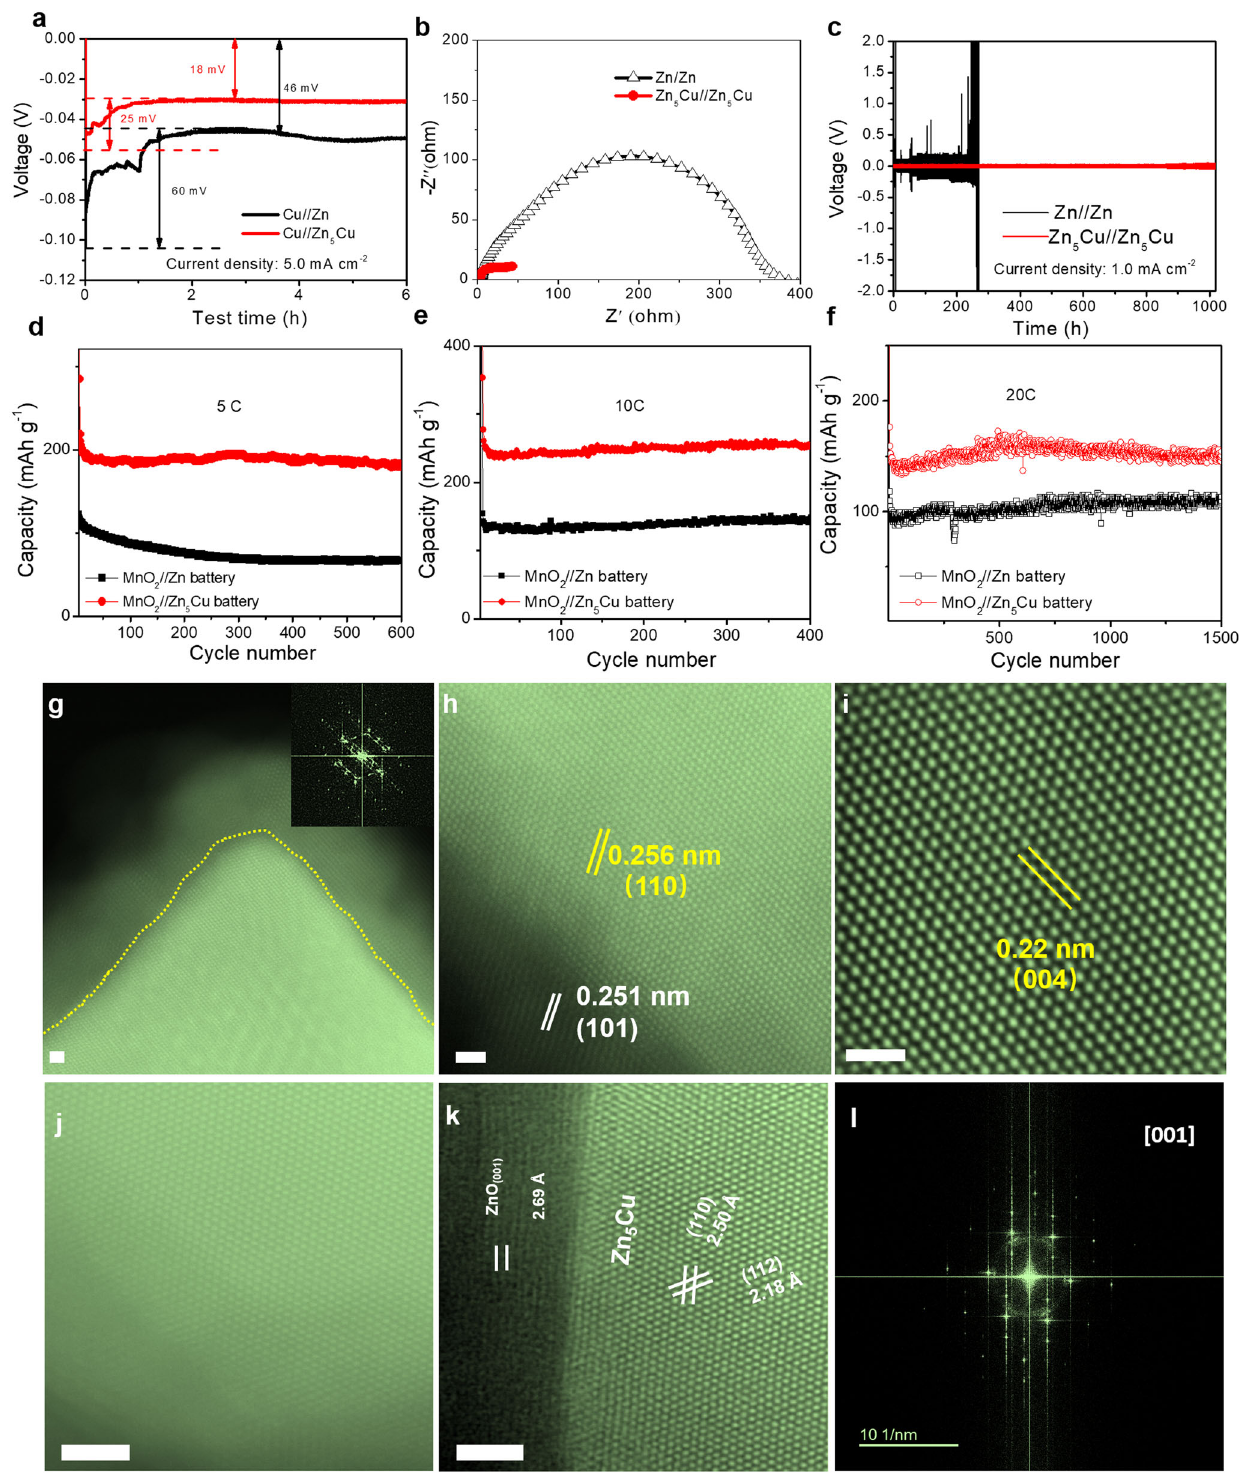
Fig. 2 | Electrochemical performance and structure characterizations of Zn-Cu anode in aqueous Zn batteries. a Nucleation overpotentials of Zn-Cu and Zn asymmetric cells ( vs . Cu electrode) at a current density of 5.0mAcm − 2 . b Electrochemicalimpedancespectroscopy(EIS)ofZn//ZnandZn-Cu//Zn-Cucells. c Long-term stability of Zn//Zn and Zn-Cu//Zn-Cu cells at a current density of